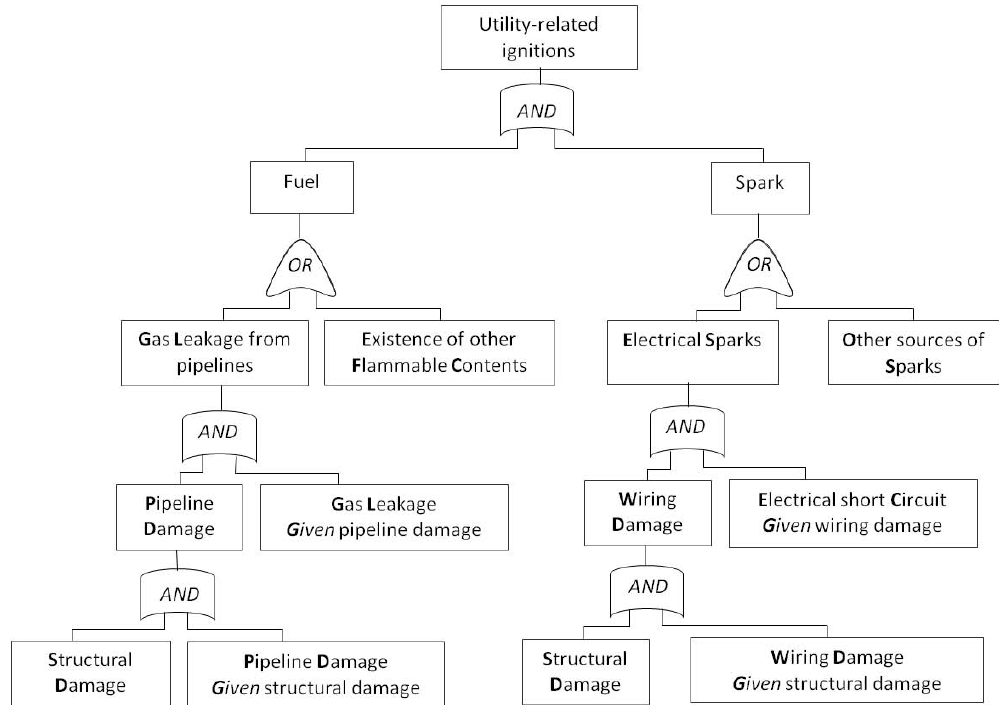
Fig. 2. Event tree of ignition probability caused by damaged utility systems (Peyghaleh, 2006).